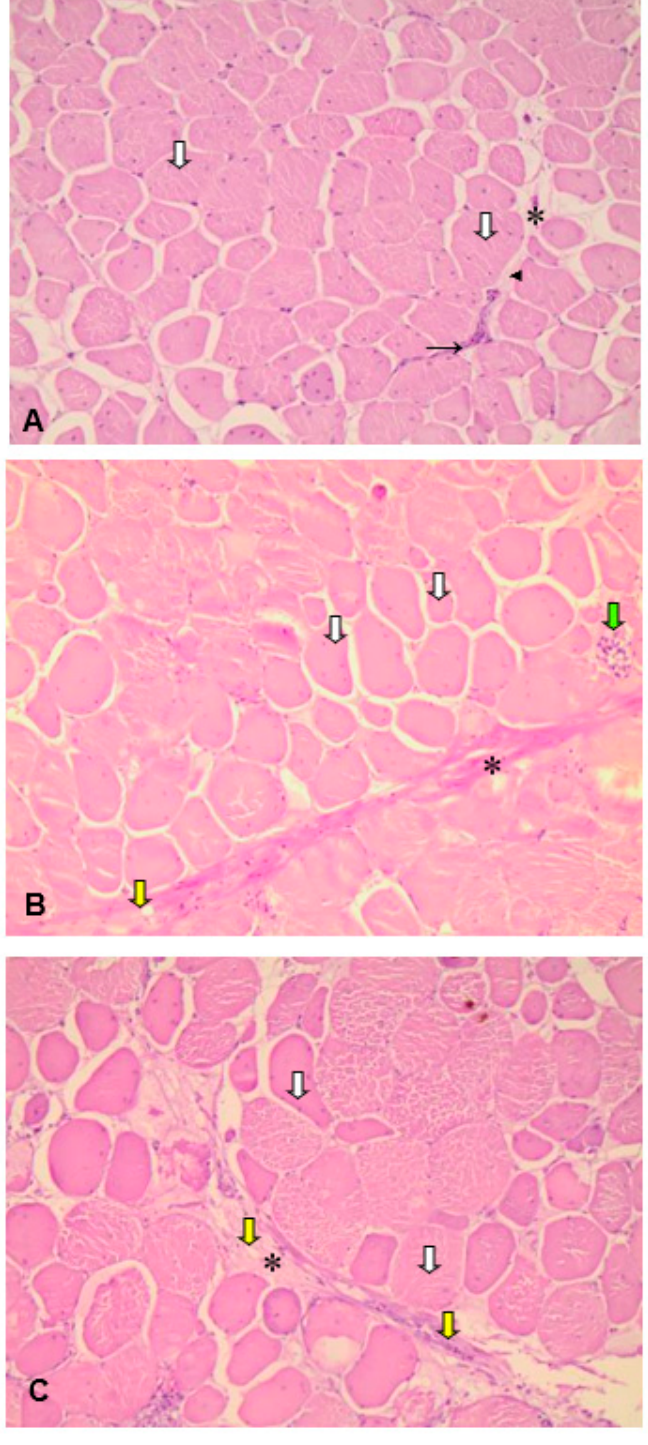
Figure 2. Photomicrographs of histological cross sections of Pectoralis major muscle from broilers affected by wooden breast ( n = 20, for each group). ( A ) Normal. Muscle fiber (white arrow); perimysium (*); extracellular matrix (arrowhead); fibroblasts (black arrow). ( B ) Moderate aspect of the wooden breast. Muscle fiber (white arrow); perimysium (*); degenerated muscle fiber infiltrated by inflammatory cells (green arrow); adipocytes (yellow arrow). ( C ) Severe aspect of wooden breast. Muscle fiber (white arrow), perimysium (*), adipocytes (yellow arrows). HE, 200×.